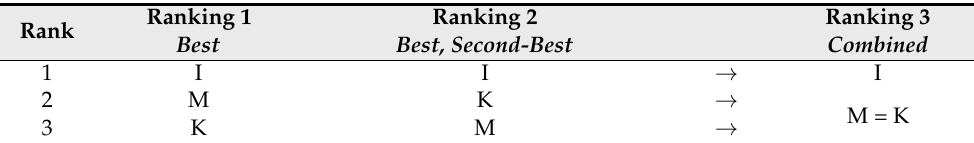
Table 5. Best-ranking of selected